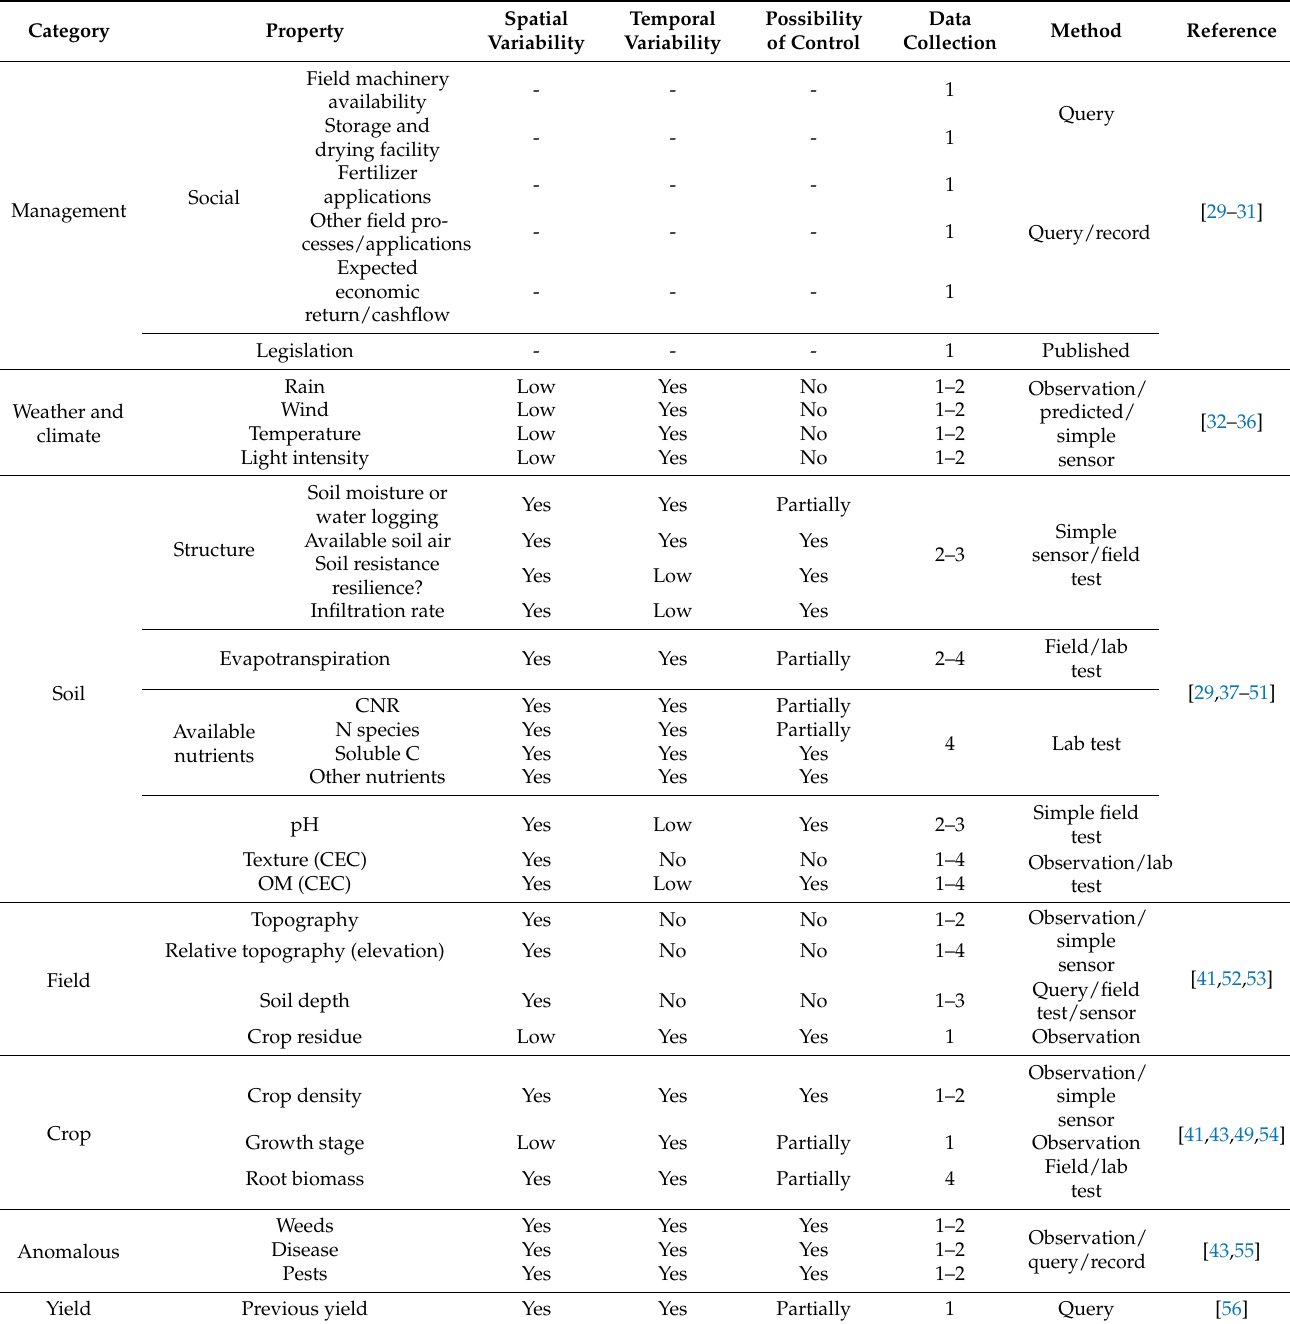
Table 1. Summary of the key literature identifying priority properties by category, importance of spatial and temporal variability at field scale, the possibility of management control (yes, no, low, partially), and the method and ease of data collection (1 = easy, 4 =